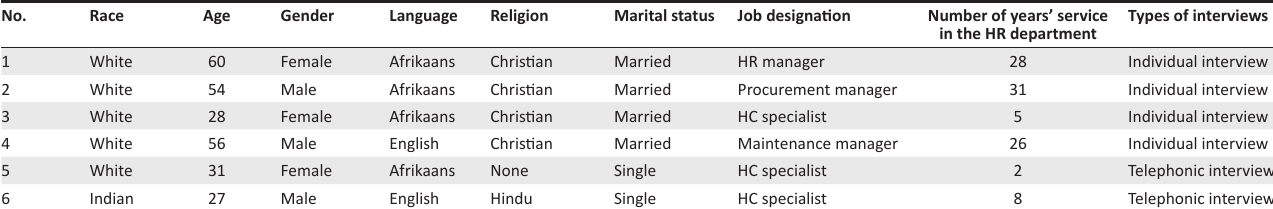
TABLE 1: Biographical characteristics of the participants in this study.